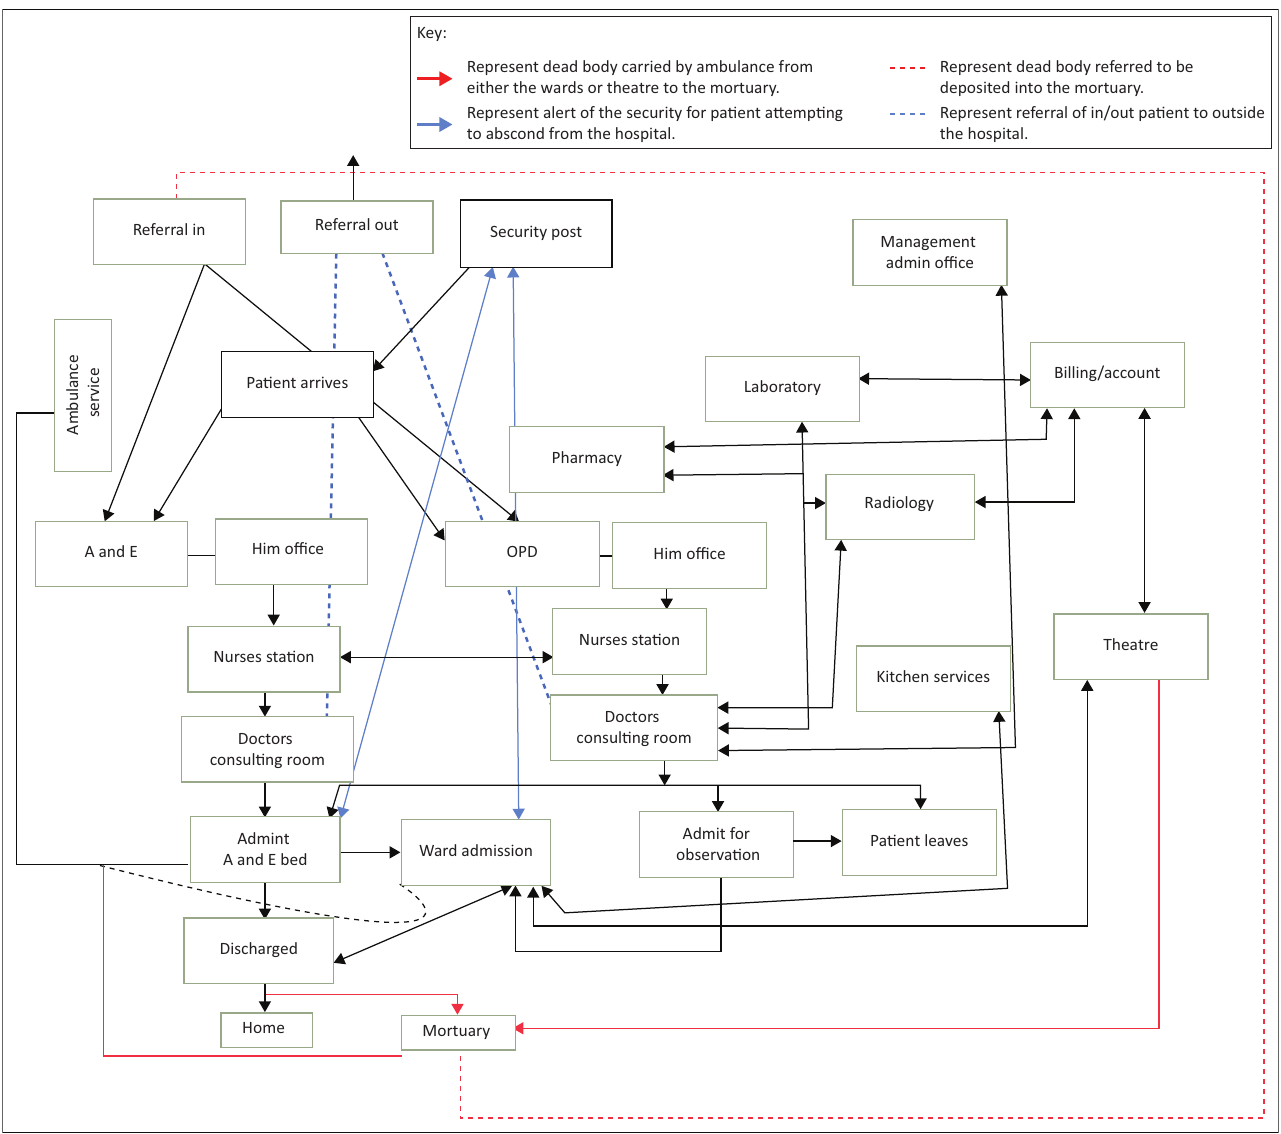
FIGURE 7: The proposed standard electronic health record communication